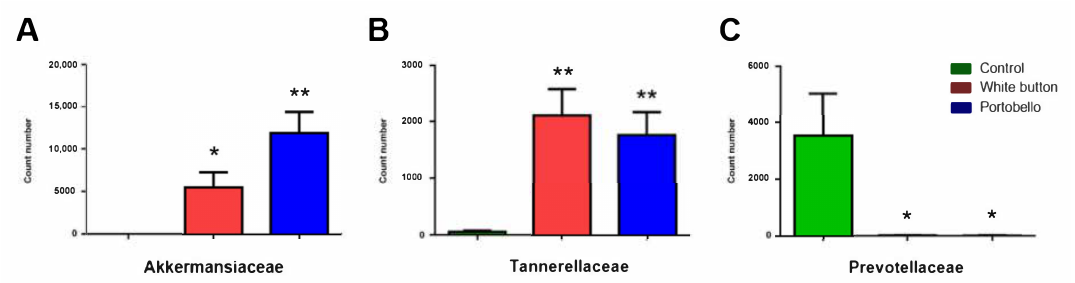
Figure 3. Count numbers for some bacterial families, including Akkermansiaceae ( A ), Tannerellaceae ( B ), and Prevotellaceae ( C ). Bars represent the mean and standard error of the mean (SEM) of all measurements ( n = 10). *: p < 0.05 and **: p < 0.01 versus